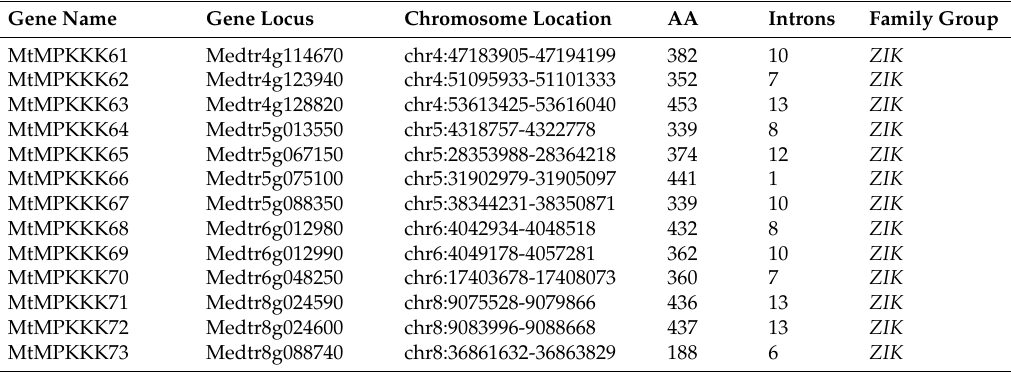
Table 2. List of all MtMAPKKK genes identified in the Medicago truncatula genome.